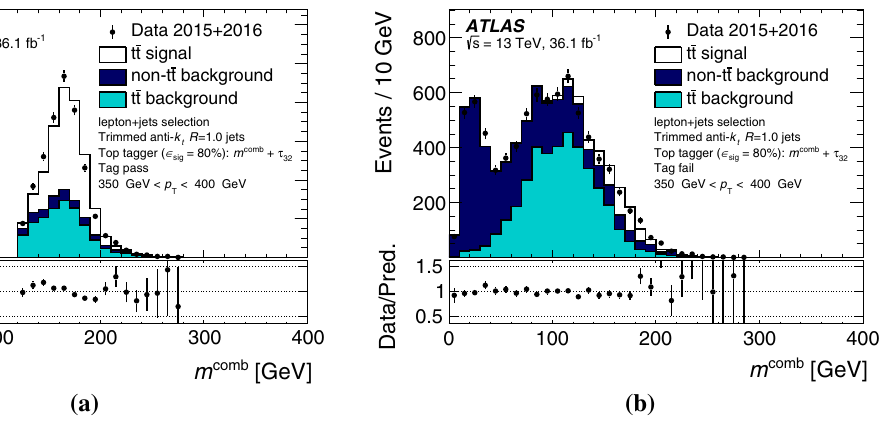
sationfactors.Thefirst, t ¯ t signal , includesonlythe t ¯ t ( top ) contribution, while t ¯ t background includes contributions from t ¯ t ( W ) and t ¯ t ( other ) and the non-t ¯ t background component includes all other backgrounds. Only statistical uncertainties are